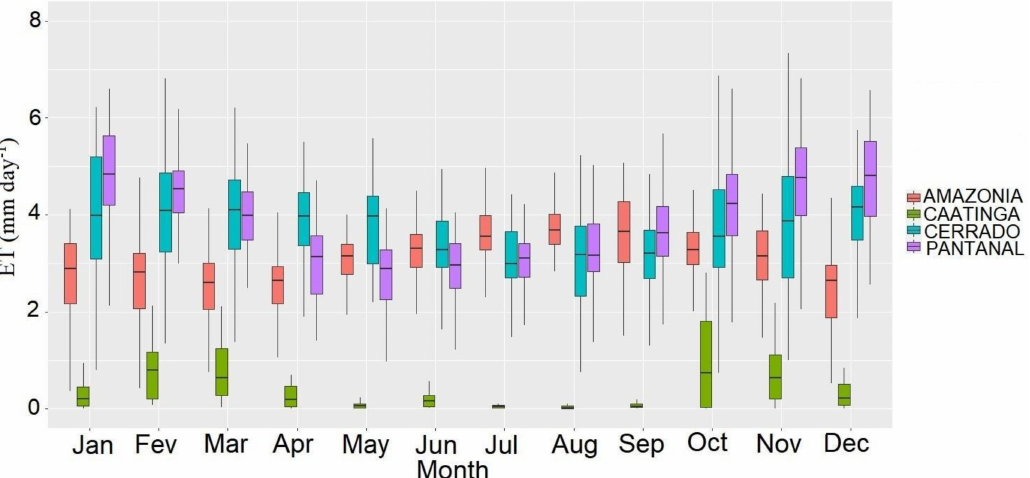
Figure 5. Monthly daily evapotranspiration (mm day − 1 ) boxplots for each site and studied pe- riod (Amazonia: 2009 − 2011; Caatinga: January 2014 − July 2015; Cerrado: 2004 − 2006; Pantanal: 2015 −